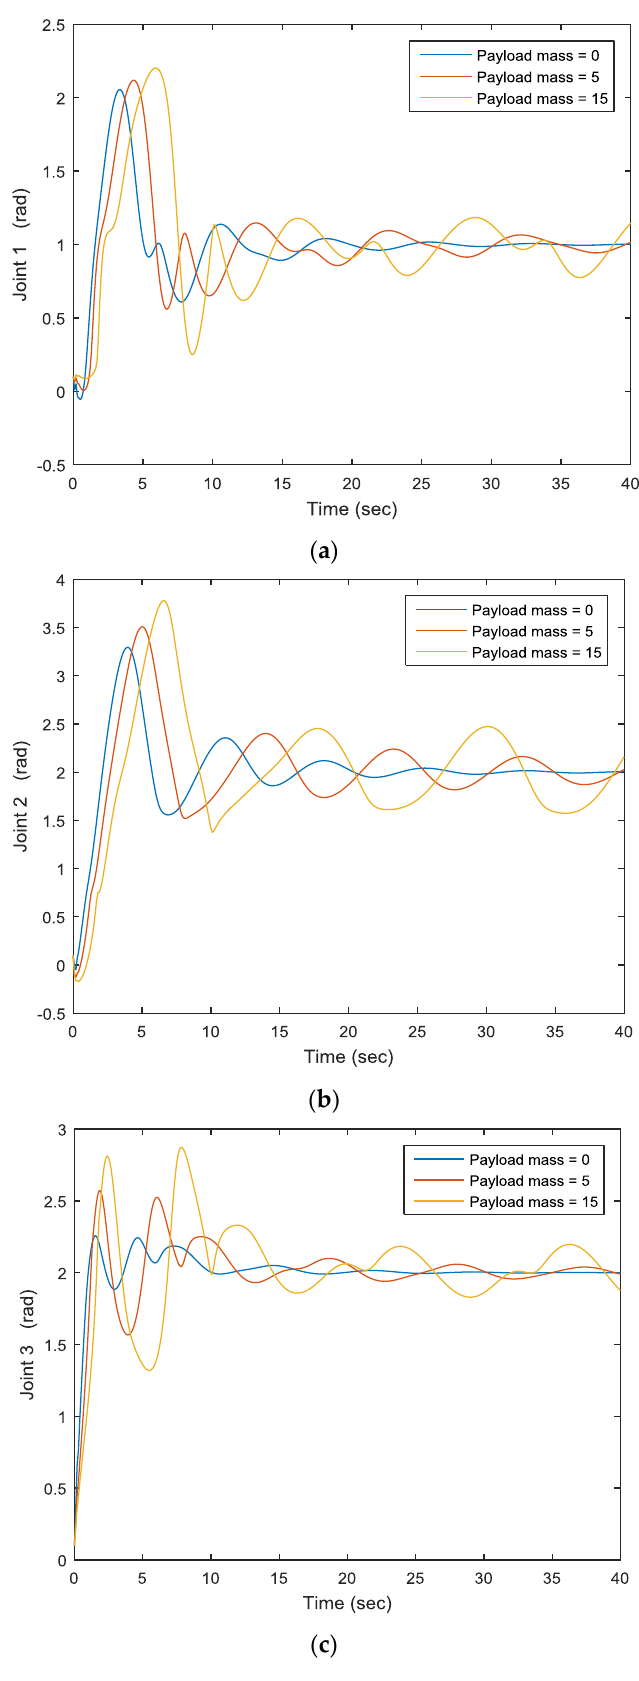
Figure 7. The output of joint 1 ( a ), joint 2 ( b ) and joint 3 ( c ).